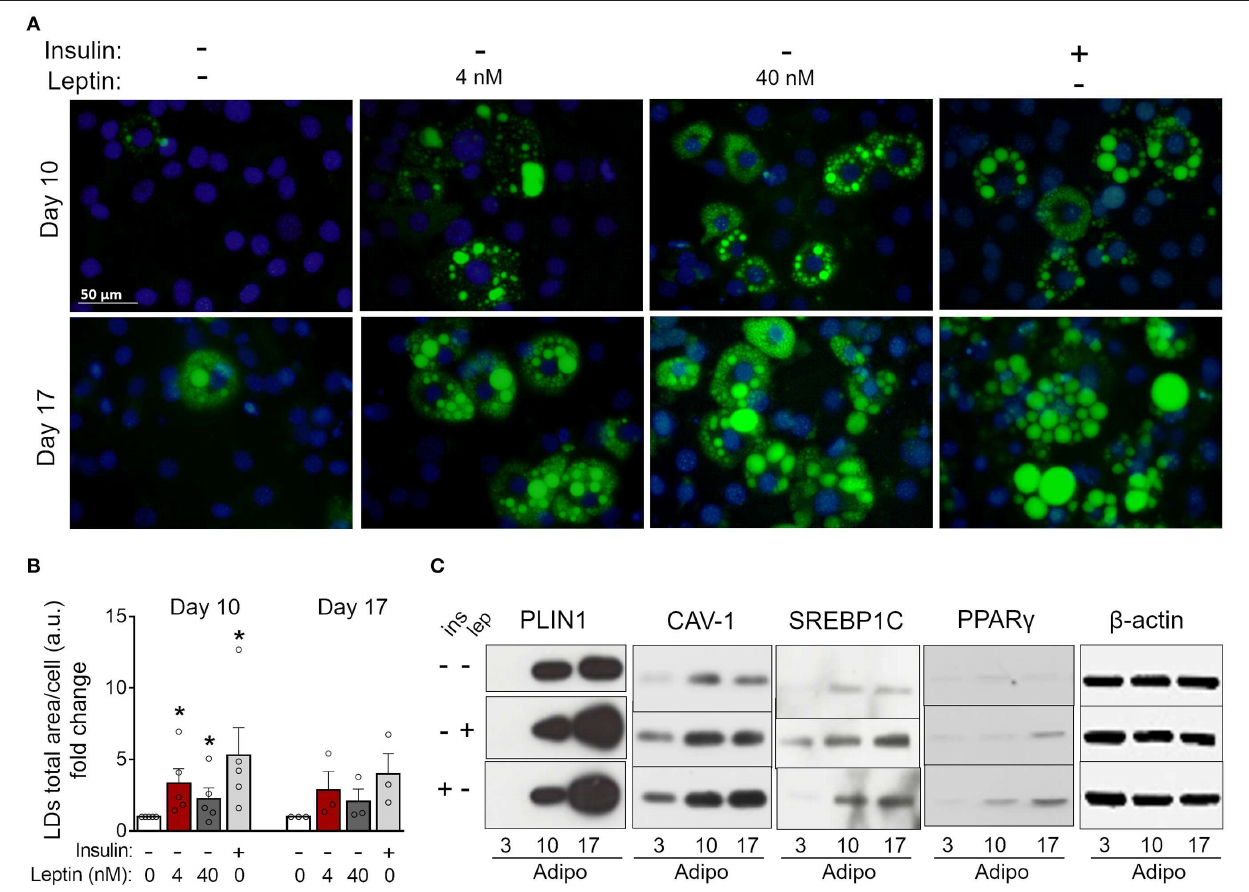
FIGURE 4 | Leptin recovers 3T3-L1 differentiation in the absence of insulin. 3T3-L1 adipocytes were cultured with no hormone, insulin or leptin (4 or 40nM) up to 3, 10, or 17 days after induction of differentiation. (A) Fluorescence images of cells stained with Bodipy (green) for lipid droplets and DAPI (blue) for nuclei. Images are representative of 3–5 independent experiments. Scale bar represents 50 µ m. (B) Quantification of the green area per cell in each field. Data are depicted as the fold change relative to the group with no hormone supplementation. Bars represent mean ± standard error of the mean of 3–5 independent experiments. (C) Western blot analysis of PLIN1, CAV-1, SREBP1C, PPAR γ , and β -actin. Blots are representative of three independent experiments in the cases of PLIN1, CAV-1, and PPAR γ and two independent experiments in the case of SREBP1C. Cell lysates were analyzed in the same gel and cropped for clearer comparison among groups. * p < 0.05 relative to the group in which cells were cultured with neither insulin nor leptin. Statistical analyzes were performed by using the Kolmogorov-Smirnov test.